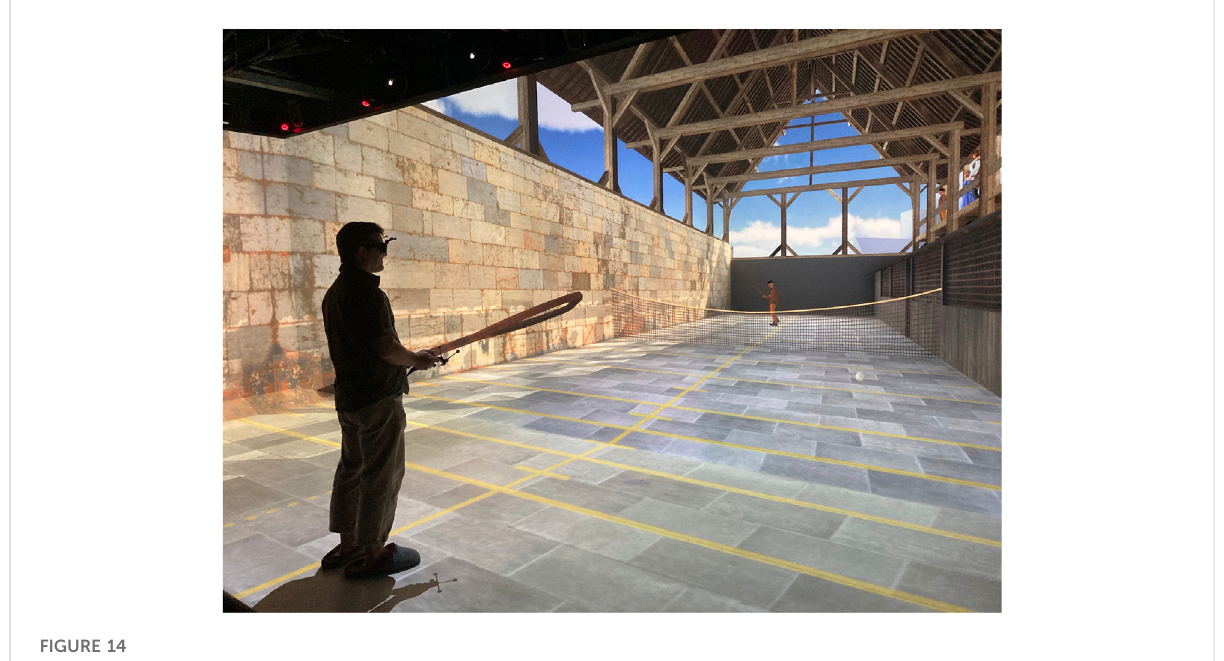
FIGURE 14 Virtual real tennis in a large cave